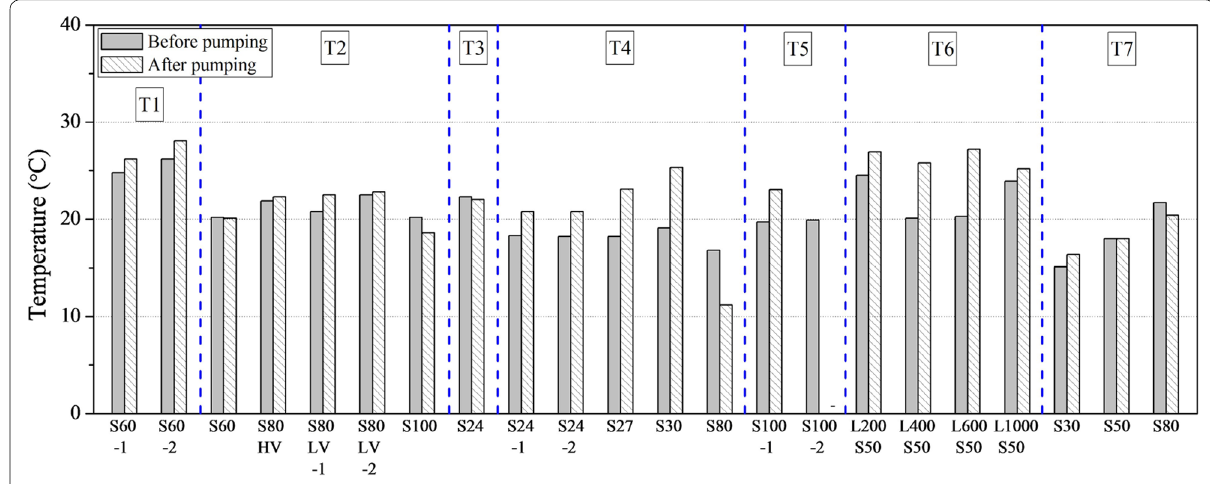
Fig. 4 Results of temperature from the real-scale pumping tests.